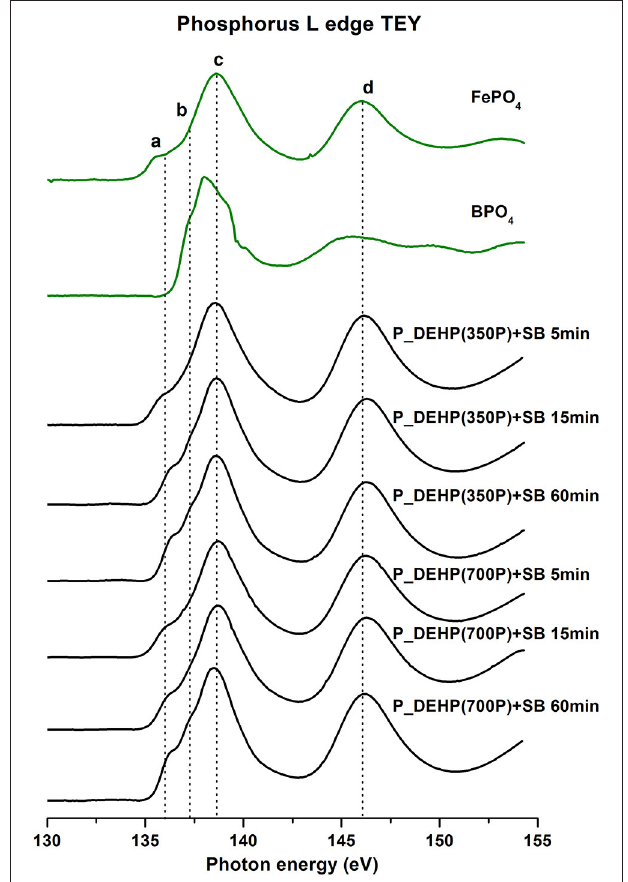
FIGURE 7 | Phosphorus L-edge TEY spectra of tribofilms (black lines) derived at 5, 15, and 60min test for P_DEHP(350P) + SB and P_DEHP(700P) + SB lubrication along with model compounds (green